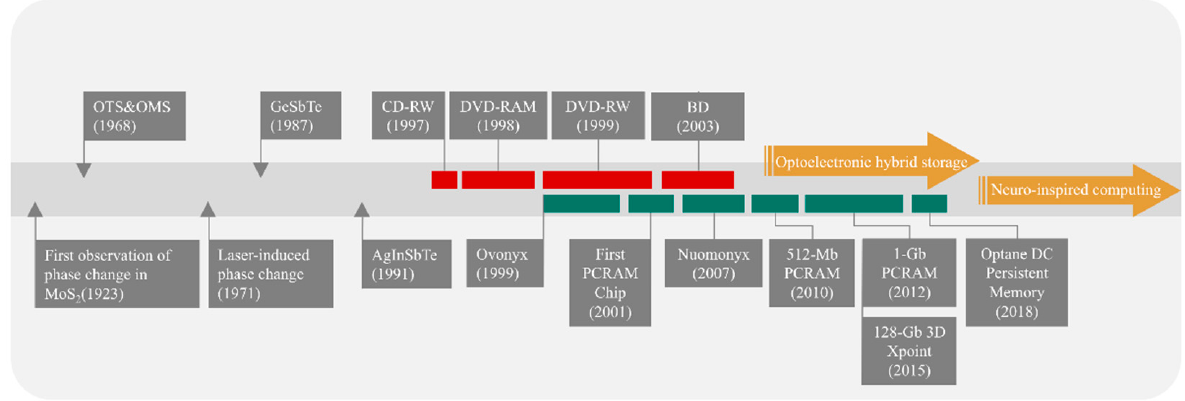
Figure 6. The development history of phase change materials.